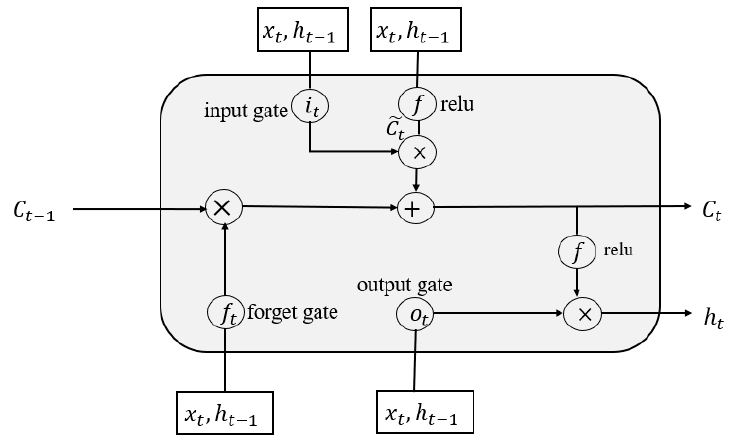
Figure 2. The structure of neuron of LSTM.